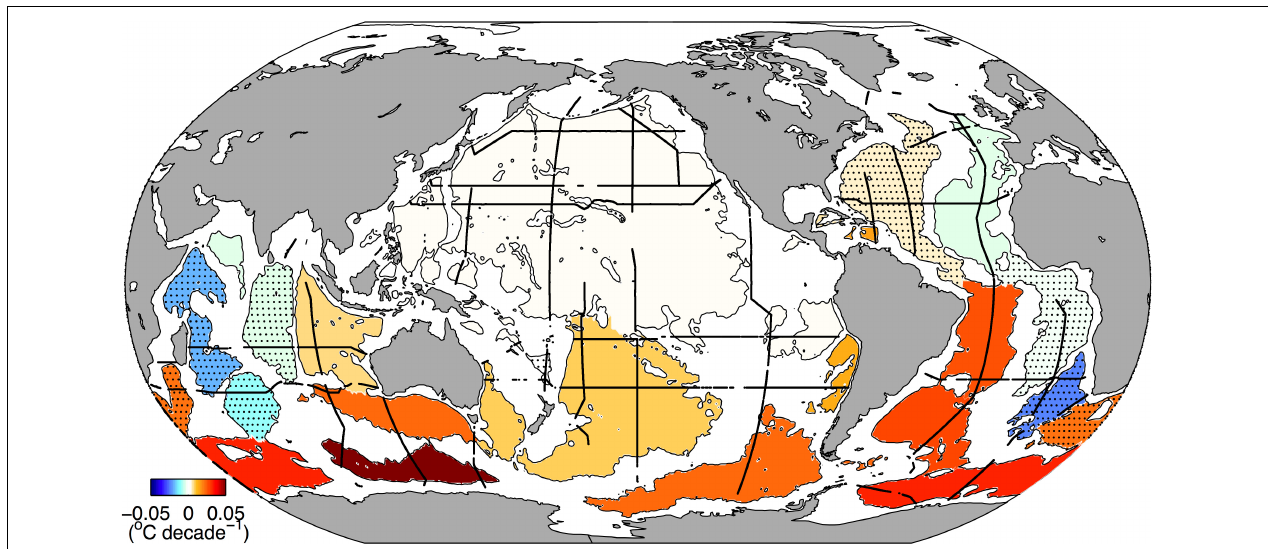
FIGURE 2 | Deep basin (thin solid lines) average warming rates below 4,000 m from the 1990s to the 2000s ( ◦ C decade – 1 , colorbar) based on data from Purkey and Johnson (2010). Estimates are based on data from decadal repeats of hydrographic sections (thick solid lines) first occupied during the World Ocean Circulation Experiment (WOCE) (King et al., 2001) and subsequently by the Global Ocean Ship-based Hydrographic Investigations Program (GO-SHIP) (Talley et al., 2016). Stippled basins have average warming rates that are not statistically significantly different from zero at 95% confidence. Permission obtained for use of figure.